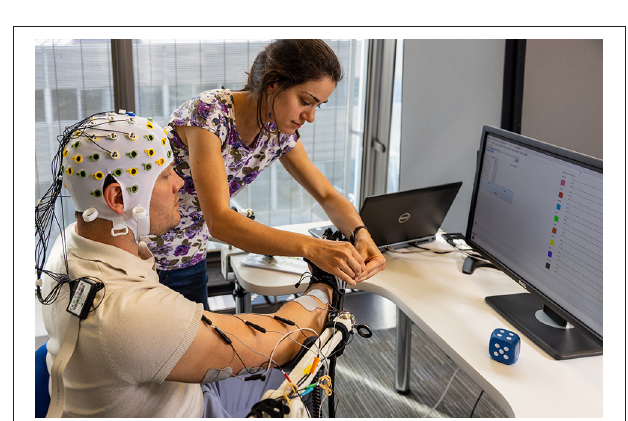
FIGURE 2 | Interventional setup. The patient is sitting on a comfortable chair with the arm resting on an anti-gravity support; multiple FES electrodes are placed over the upper-limb; and the hand is placed in the robotic glove, which the therapist is adjusting. The subject is wearing an EEG cap for the BCI. On the computer screen the in-house application through which the therapy session can be run is